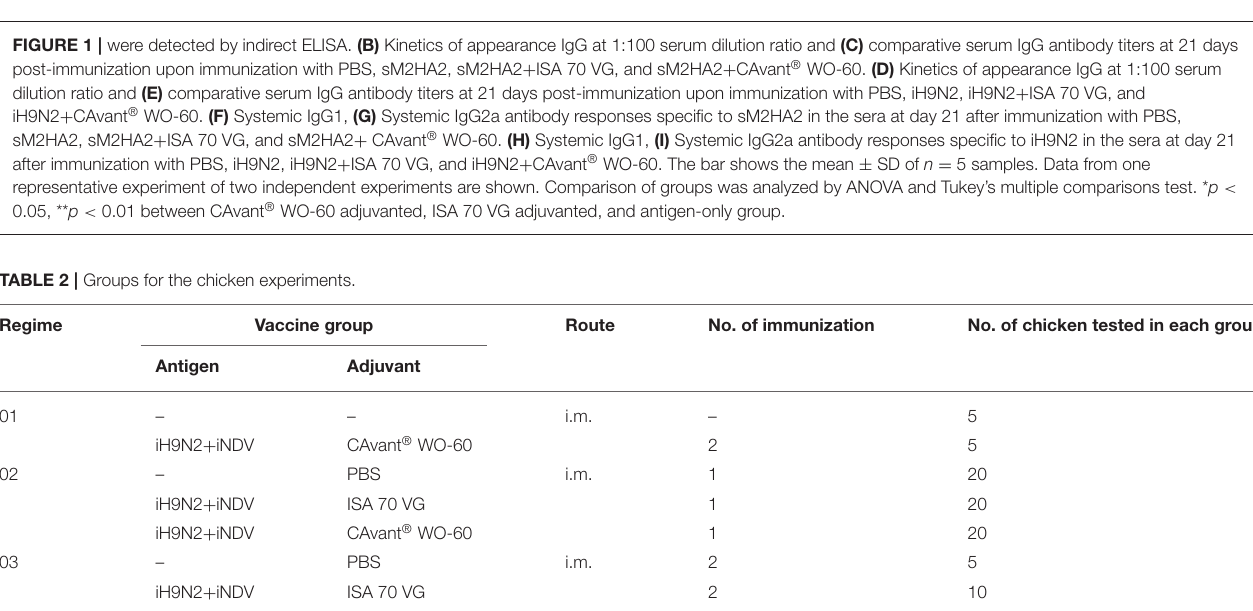
FIGURE 1 | were detected by indirect ELISA. (B) Kinetics of appearance IgG at 1:100 serum dilution ratio and (C) comparative serum IgG antibody titers at 21 days post-immunization upon immunization with PBS, sM2HA2, sM2HA2 + ISA 70 VG, and sM2HA2 + CAvant ® WO-60. (D) Kinetics of appearance IgG at 1:100 serum dilution ratio and (E) comparative serum IgG antibody titers at 21 days post-immunization upon immunization with PBS, iH9N2, iH9N2 + ISA 70 VG, and iH9N2 + CAvant ® WO-60. (F) Systemic IgG1, (G) Systemic IgG2a antibody responses specific to sM2HA2 in the sera at day 21 after immunization with PBS, sM2HA2, sM2HA2 + ISA 70 VG, and sM2HA2 + CAvant ® WO-60. (H) Systemic IgG1, (I) Systemic IgG2a antibody responses specific to iH9N2 in the sera at day 21 after immunization with PBS, iH9N2, iH9N2 + ISA 70 VG, and iH9N2 + CAvant ® WO-60. The bar shows the mean ± SD of n = 5 samples. Data from one representative experiment of two independent experiments are shown. Comparison of groups was analyzed by ANOVA and Tukey’s multiple comparisons test. * p < 0.05, ** p < 0.01 between CAvant ® WO-60 adjuvanted, ISA 70 VG adjuvanted, and antigen-only group.